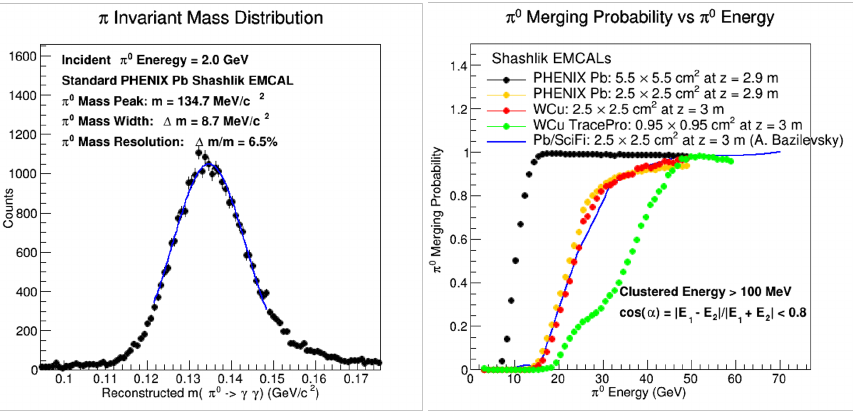
Figure 2. The invariant mass of π 0 reconstructed from the two photon (left) with the EMCAL and π 0 merging probability as a function of π 0 energy with di ff erent EMCAL designs (right) are shown above. Only cluster counting information is used to determine the π 0 merging probability. We did not look into the shower profiles of the clusters to distinguish a single photon or two